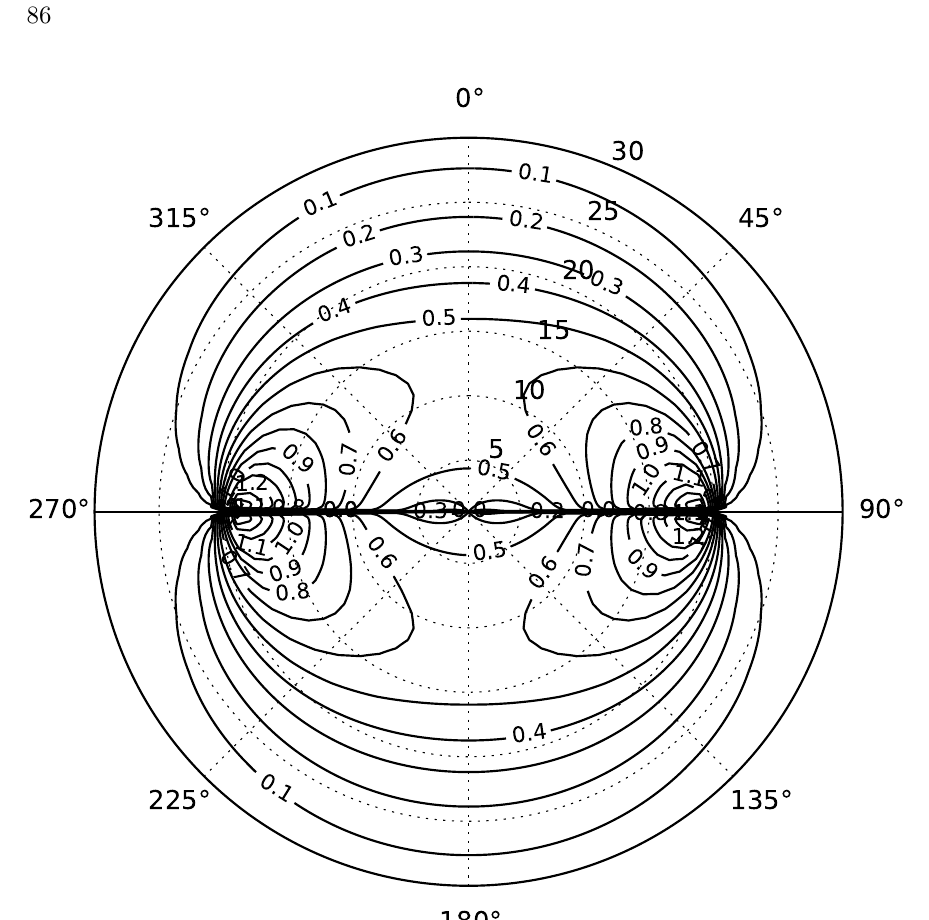
Fig. 3. Isolines of the azimuthal correction factor of the gravitational potential, C . The coordinates are the same as in Figure 1. Similarly to the gravitational potential, in the outer region free of isolines the value of C asymptotically approaches to